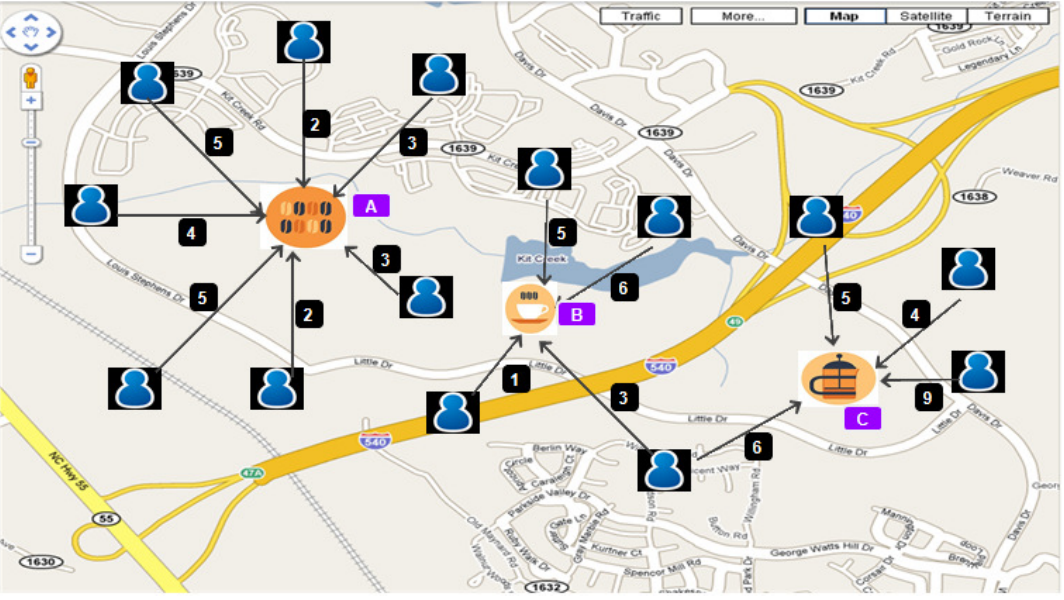
Figure 2. Example